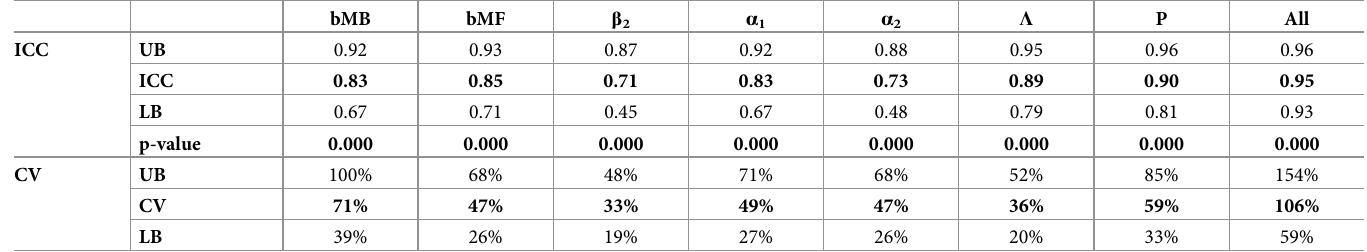
Table 5. Test-retest reliability and repeatability of model parameters. Intraclass Correlation Coefficients (ICC) assessing reliability and Coefficients of Variation (CV) assessing repeatability of the seven parameters (bMB, bMF, β 2 , α 1 , α 2 , λ , p ). Upper (UB) and lower bounds (LB) of confidence intervals (CI). See Fig 6 for illustration.